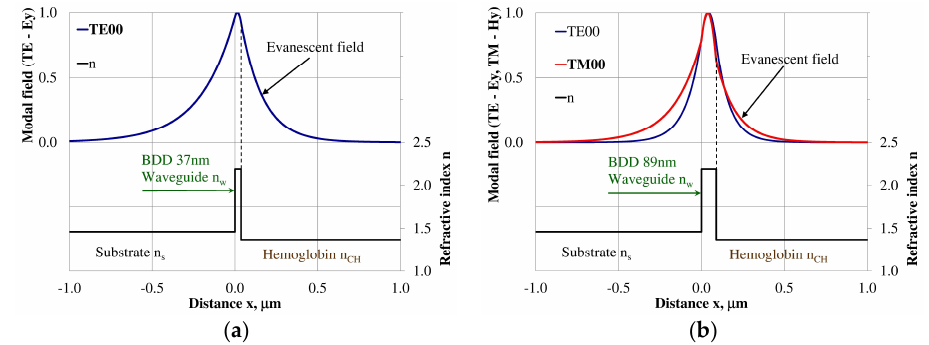
Figure 8. The modal field distribution in the single-mode BDD-based waveguide: ( a ) TE00 for maximum dN eff /dn cH , and ( b ) TM00 for maximum dN eff /dn cH .